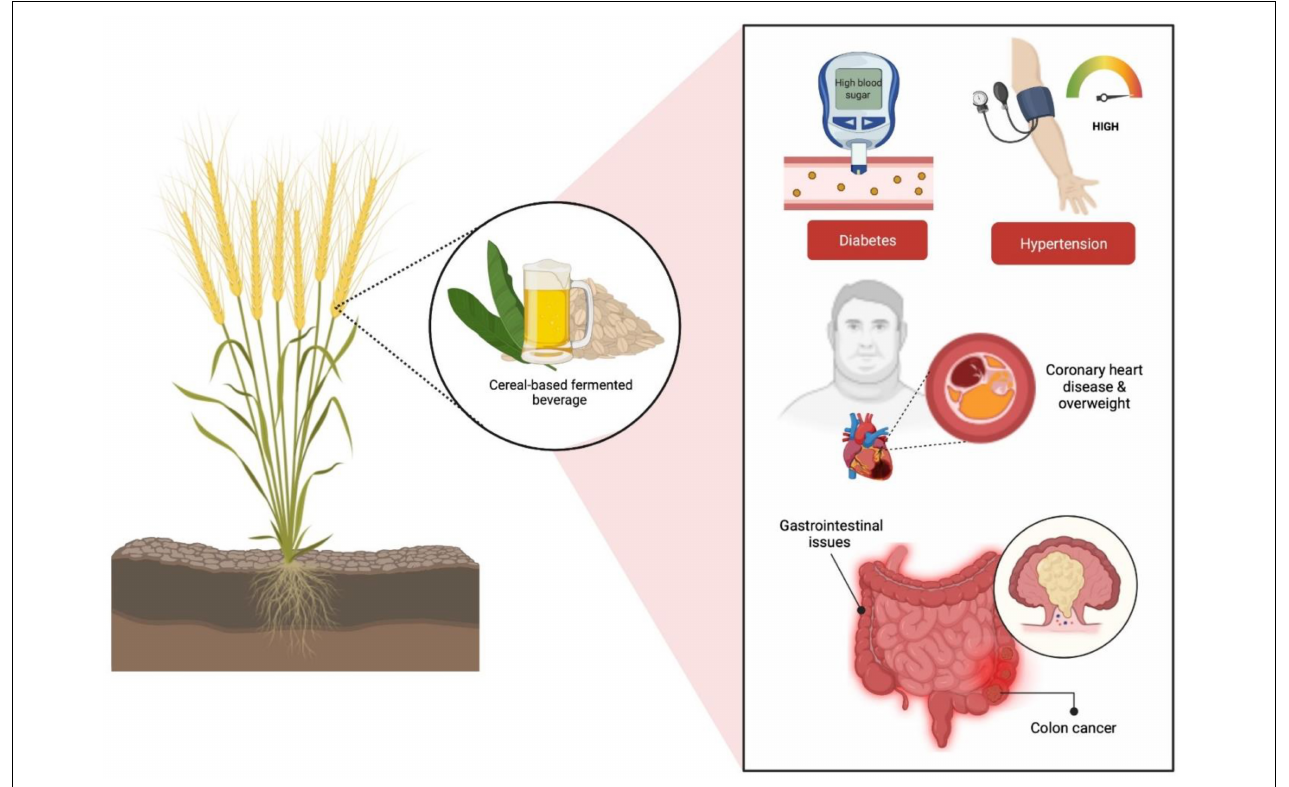
FIGURE 3 | Cereal-based fermented prebiotics have been associated to a reduction in illnesses such as obesity, diabetes, coronary heart disease, and gastrointestinal disorders (colon